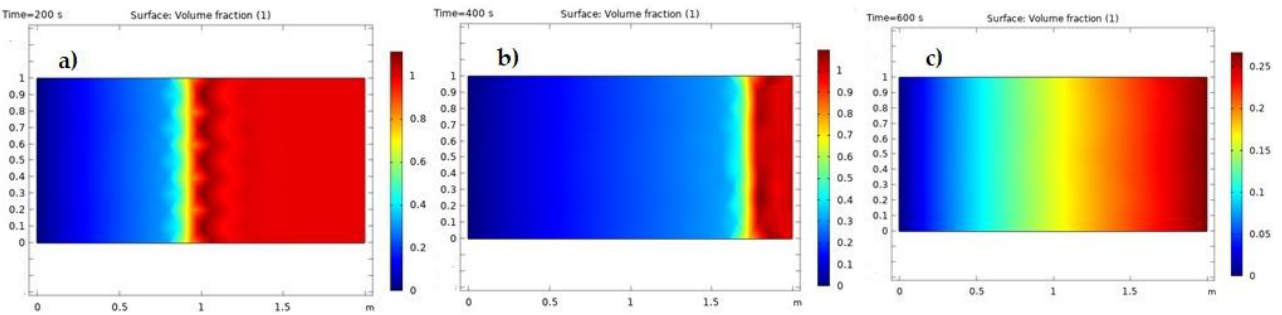
Figure 8. ( a ) Saturation of the oil at 200 s, ( b ) saturation of the oil at 400 s, and ( c ) saturation of the oil at 600 s.